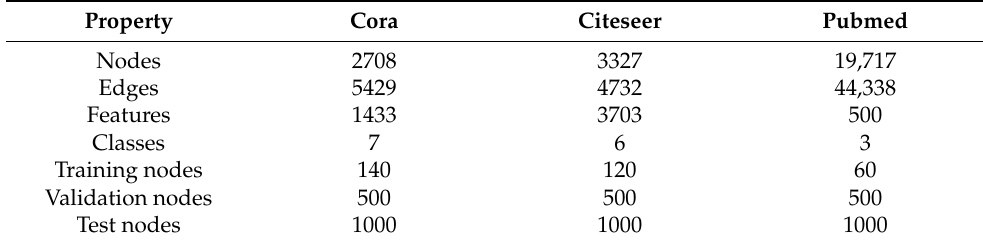
Table 3. Information of citation network datasets Cora , Citeseer and